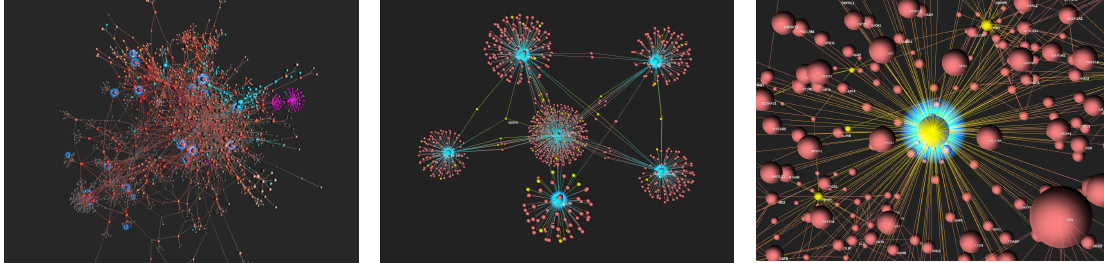
Figure 7. A few captions from the gallery of the Omicsnet website [65] rendering large biological networks with Three.js. From left to right: (1) A three-dimensional composite network composed of around 2000 nodes and 4000 edges, with halo effect on seeds, enriched pathway highlighted in light blue. (2) Omicsnet showing a force-directed miRNA-gene target network. (3) Zoomed in view the